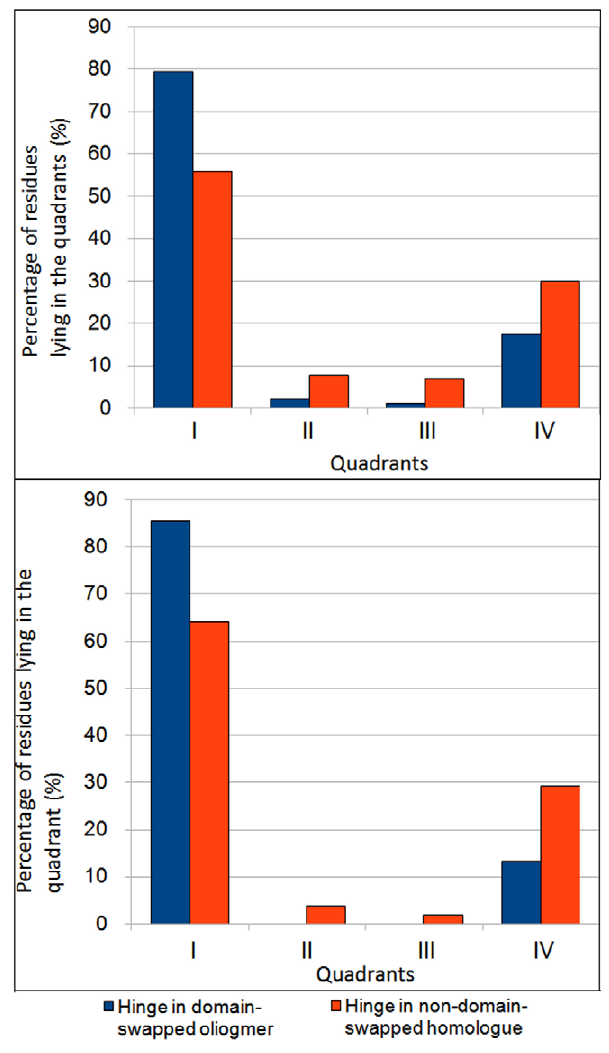
Figure 5. Distribution of backbone conformation of hinge residues where ( Q , y ) is separated into four quadrants (please see Figure 4 for regions within each quadrant). A) Percent distribution of all hinge residues in all quadrants. B) Percent distribution of non-glycine hinge residues in all quadrants.